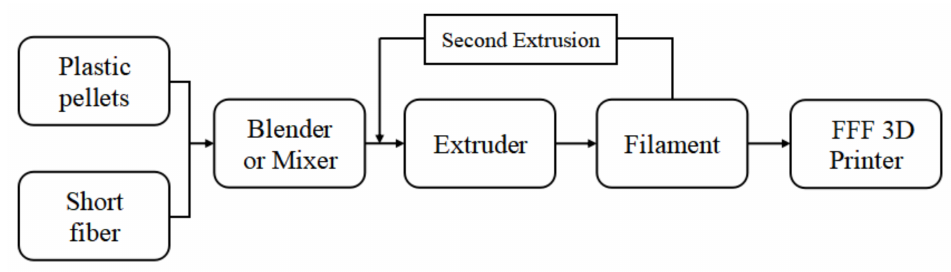
Figure 6. The flow-chart of the SFR